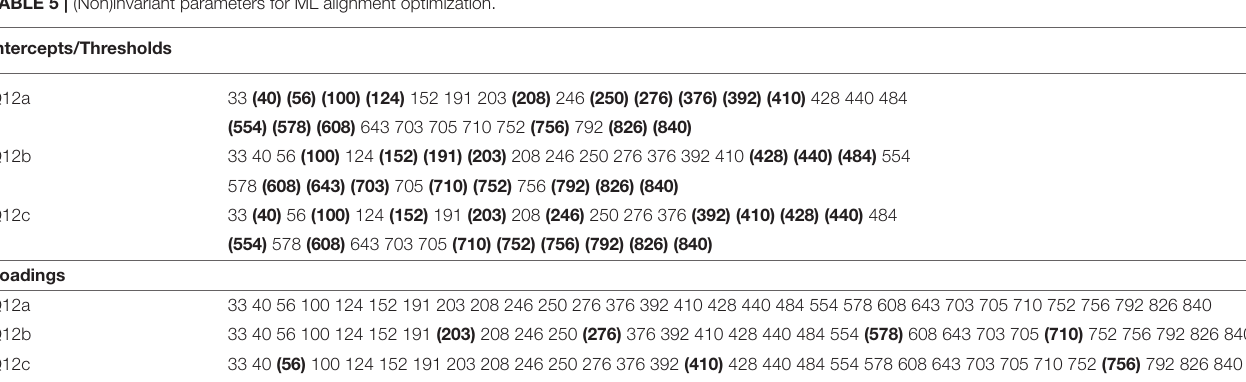
TABLE 5 | (Non)invariant parameters for ML alignment